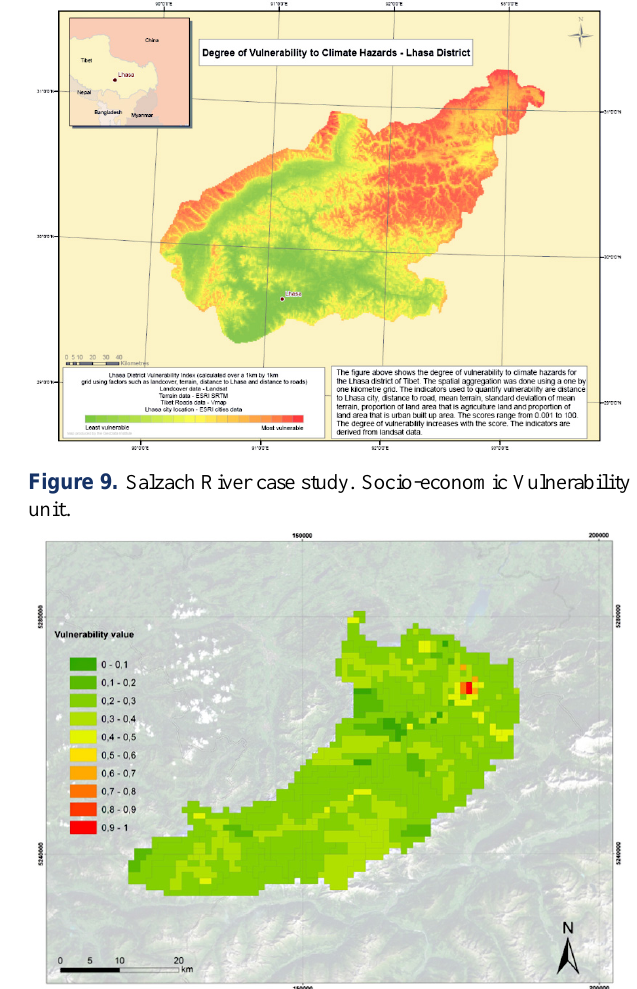
Figure 10. Lech River case study. Socio-economic Vulnerability